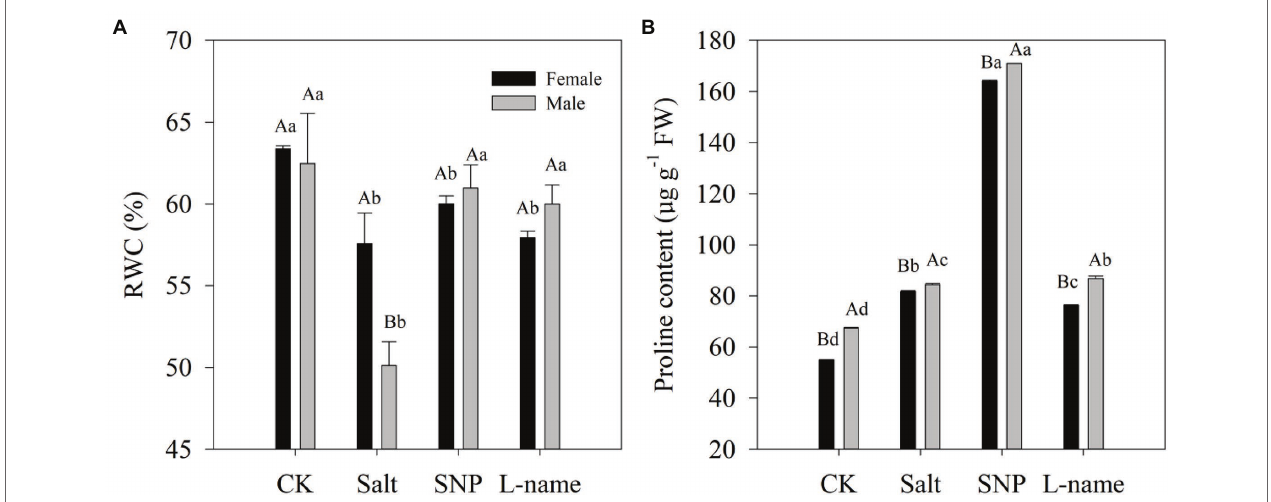
FIGURE 4 | Leaf relative water (RWC) content (A) and proline content (B) of T. grandis in response to different treatments. CK (control, distilled water), salt (100 mM NaCl), SNP (100 mM NaCl with 0.05 mM SNP), and L-name (100 mM NaCl with 0.5 mM SNP and L-name). Different uppercase letters indicate a significant difference between different genders at p < 0.05, and different lowercase letters indicate significant difference under salt treatment at p < 0.05, according to Duncan’s test.